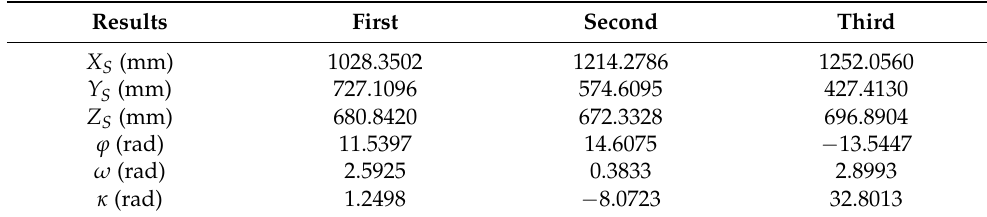
Table 9. Exterior orientation elements of three images.